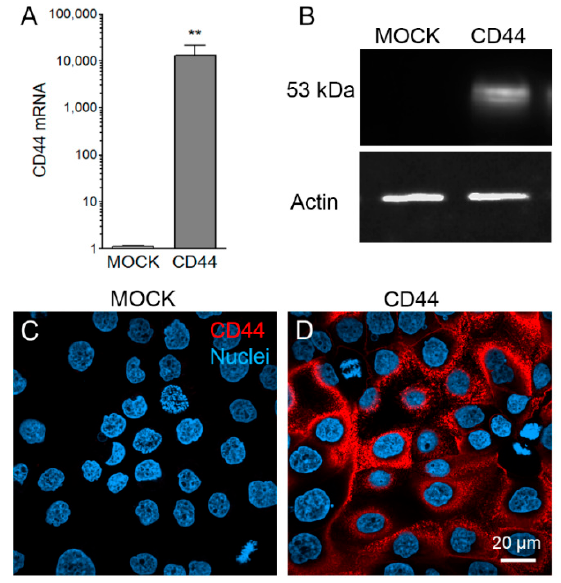
Figure 1. Characterization of CD44 expression levels in stably transfected MKN74 cells. CD44 expression levels of MOCK and CD44-positive cells analyzed by QPCR ( A ). Western blot analysis showing the abundance of CD44 proteins in CD44-positive MKN74 cell lines in while MOCK cells are negative ( B ). Immunofluorescence staining of both cell lines with monoclonal CD44 antibody shows the abundant plasma membrane staining of CD44-expressing MKN74 cells ( D ), while MOCK cells are negative for CD44 ( C ). The data represent means ± SE of 6 independent experiments in ( A ), ** p < 0.01, Mann–Whitney test.